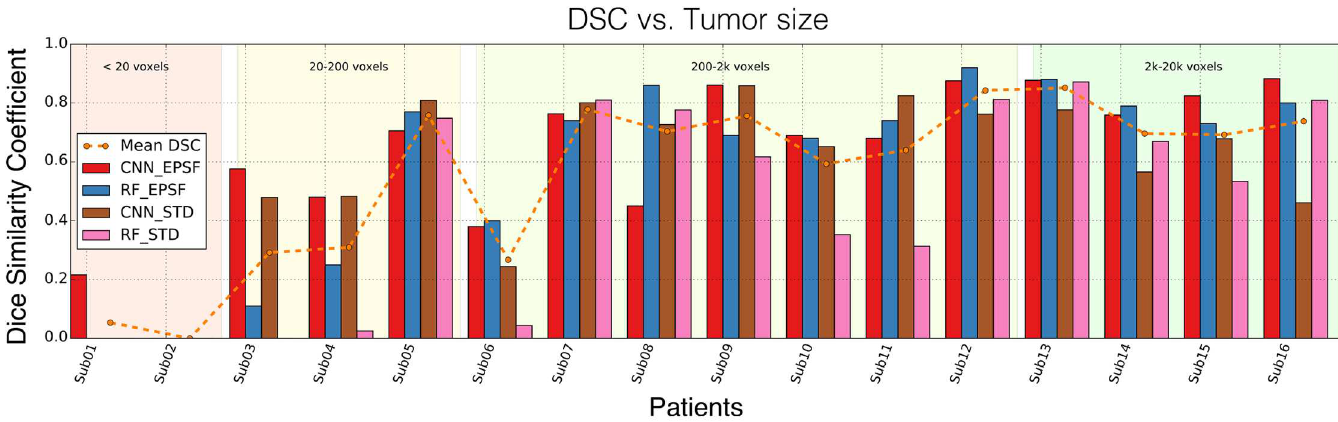
Fig 5. DSC vs. Tumor size. Average results for different combination of classifiers and feature sets. EPSF improvesoverall classificationresults over STD features